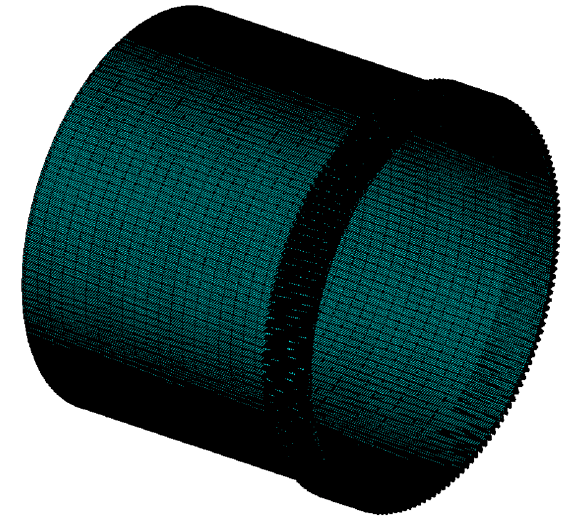
Figure 2. Finite element model of the flexible wheel. This paper focuses on the contact mechanical characteristics between the wave gen- erator and the flexible wheel. The chamfers R 1 , R 2 and R 3 , as shown in Figure 1, as well as the pin holes and smooth holes on the bottom flange of the flexspline are ignored in modeling. The flexible wheel was made of alloy structural steel 30CrMnSi, with an elastic modulus of 204 GPa, Poisson’s ratio of 0.29, density of 6691 kg/m 3 , and a yield limit of 885 MPa. When modeling, we first defined the four node plane182 element and eight node solid185 element, and completed the setting of 30CrMnSi material parameters, then generated the finite element model of a single tooth surface by using the mapping mesh division method; finally, we made the flexible wheel model corresponding to a single tooth by stretching the tooth surface, and converting the Cartesian coordinate system into the